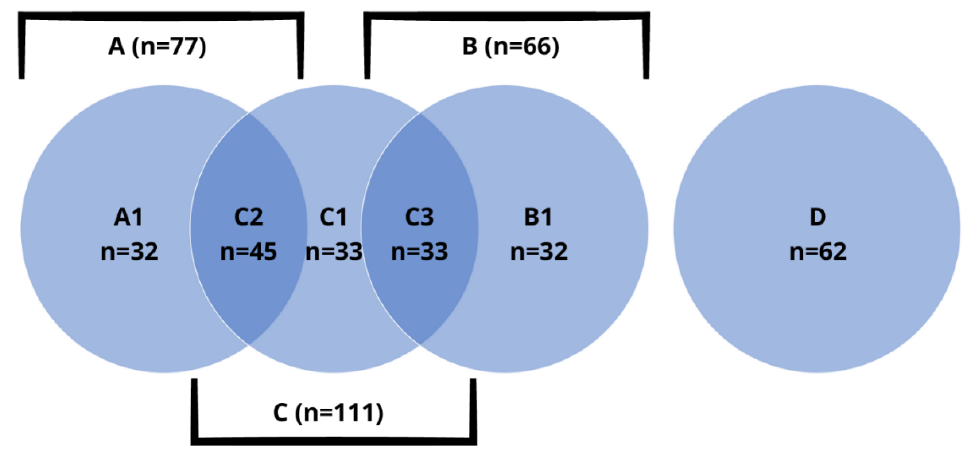
Figure 1. Groups and subgroups of patients, with exact number of subjects.